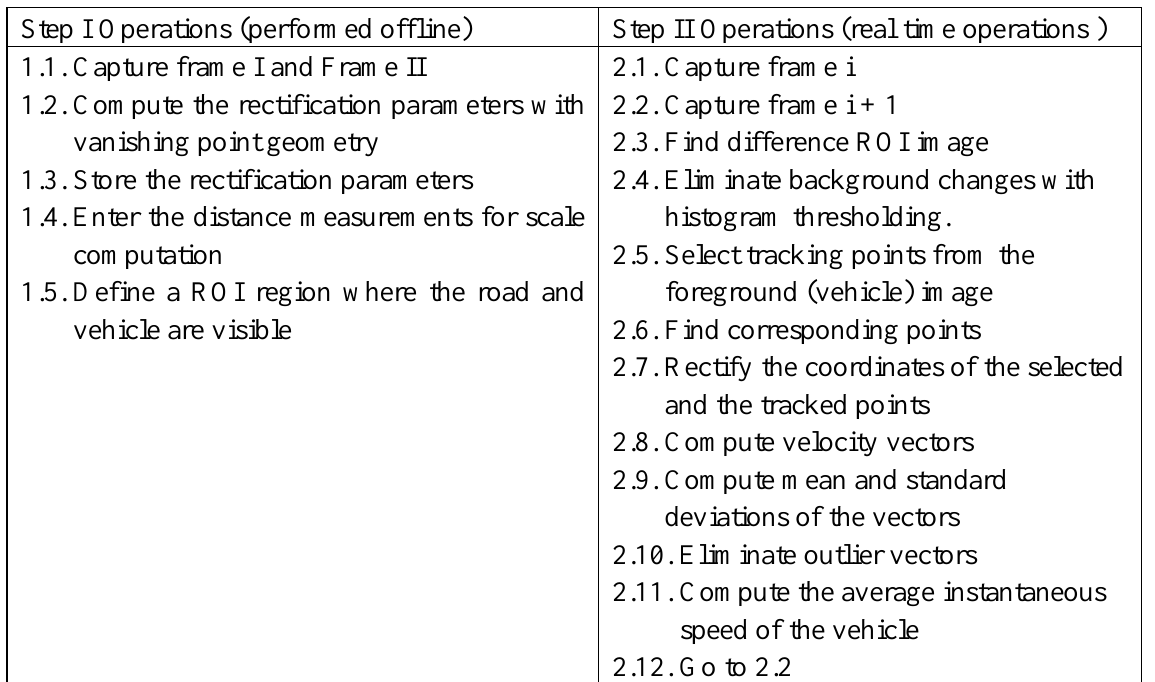
Table 1. Overall operations of proposed speed estimation